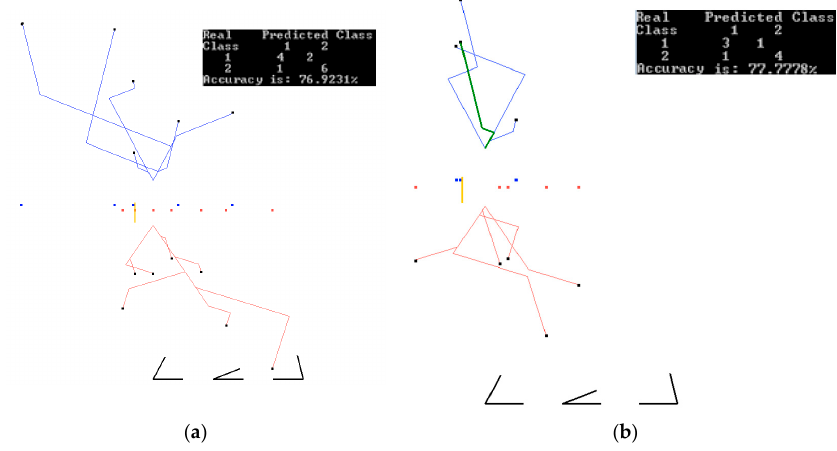
Figure 19. Run 3: data split 60%/40% ((training/validation) for the coefficients K = (0.3, 0.6, − 0.6). ( a ) Results on training data (60%) for the coefficients found on these training data; ( b ) Results on validation data (40%) for coefficients found on the training data. A green line (24 June after Brexit) is correctly classified as S&P 500 down.